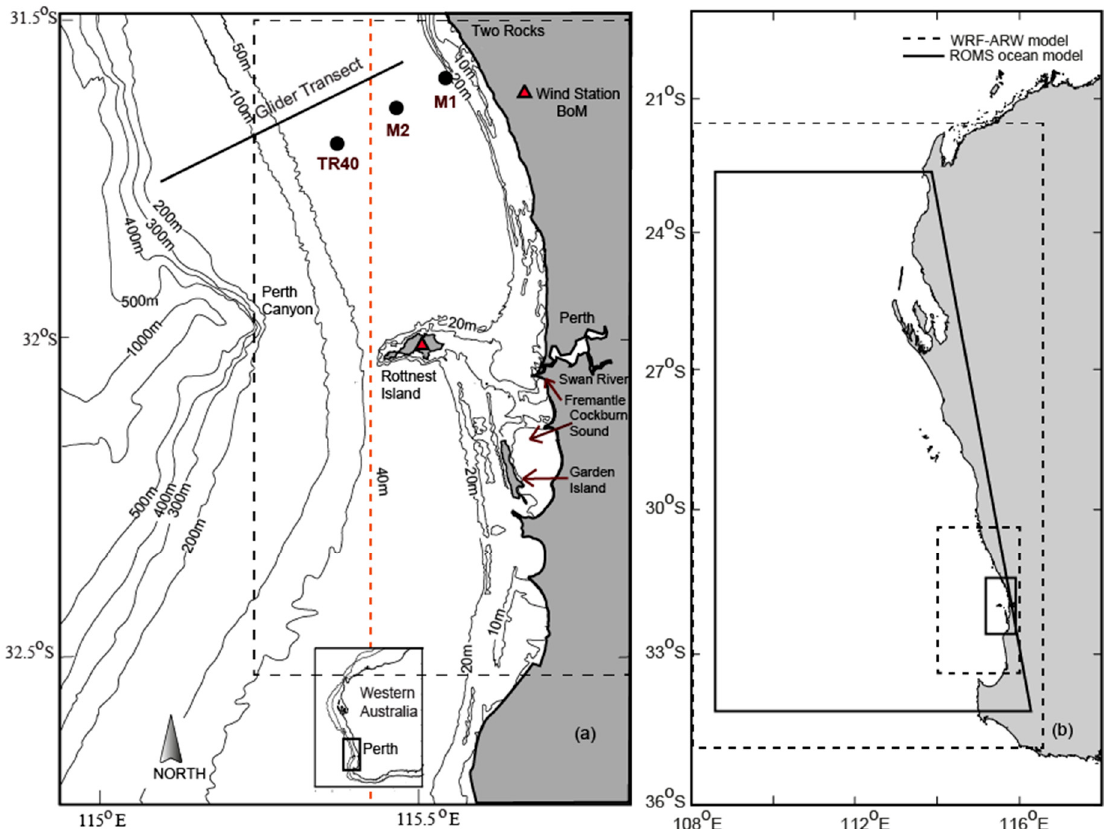
Figure 1. ( a ) Location of glider transect and mooring deployments (M1, M2, TR40) in May 2016 with the bathymetry of Two Rocks continental shelf. Wind data was used from the station situated at Rottnest Island maintained by the Bureau of Meteorology. The black dashed line represents the hydrodynamic nested model domain and red dashed line represents the sections shown on Figures 9 and 13 close to a 40 m water depth. ( b ) Large scale parent grid and nested child domain for both the Regional Ocean Modelling System (ROMS) ocean modeling system and Weather Research and Forecasting Advanced Research (WRF-ARW) model.